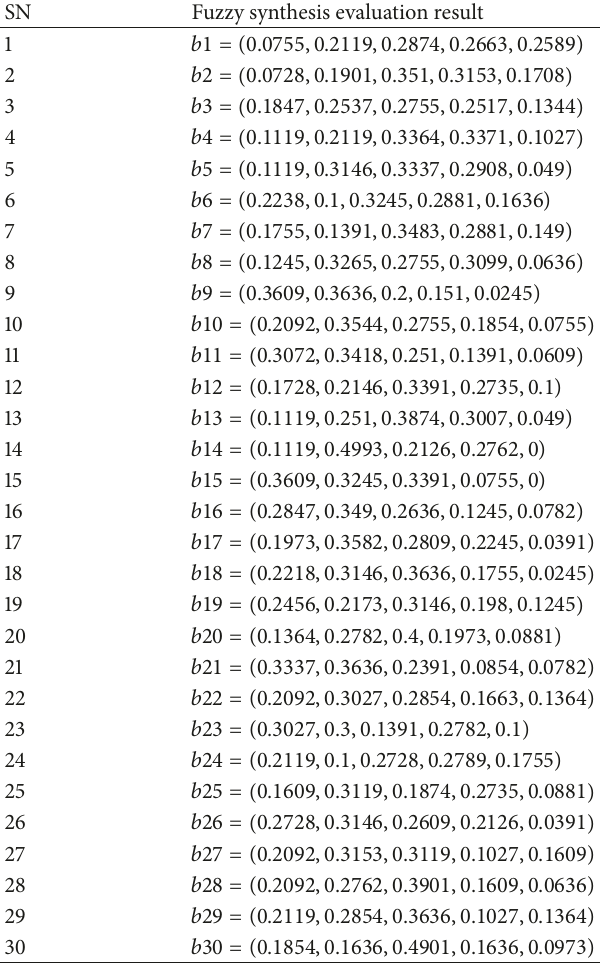
Table 6: Fuzzy synthesis evaluation